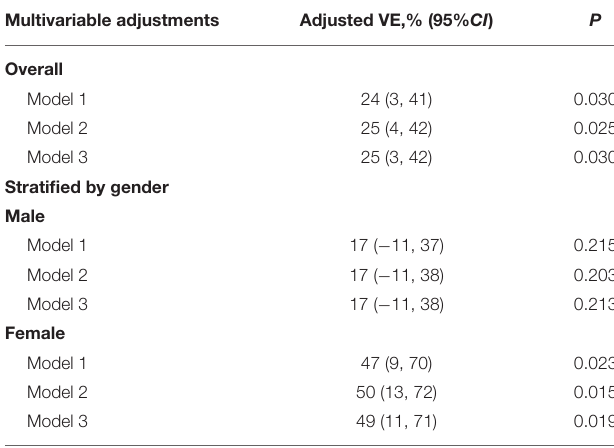
other pathogens. Model 3: Adjusted for age, medical history (respiratory related diseases, chronic underlying diseases and immune system diseases), smoking status, co-infection with other pathogens, antibiotics using before sampling and influenza vaccination